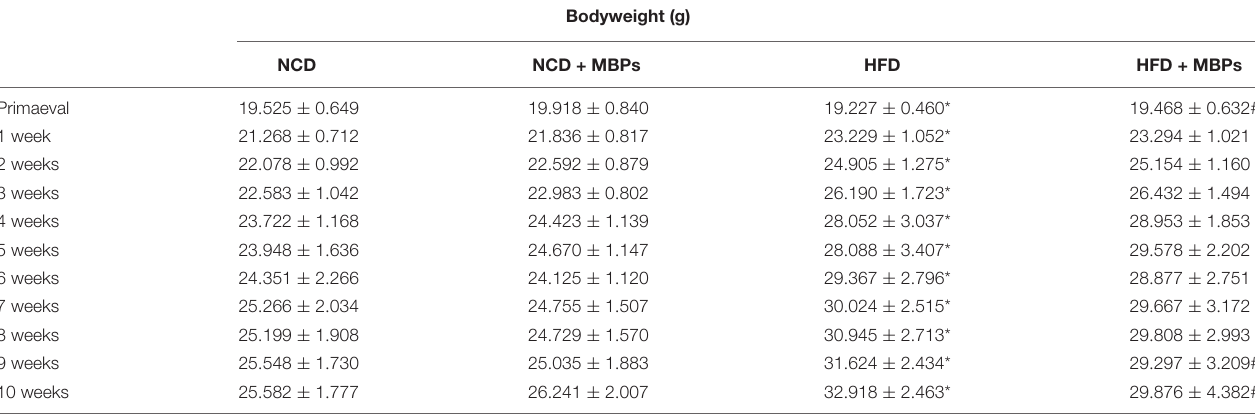
TABLE 3 | Bodyweight of